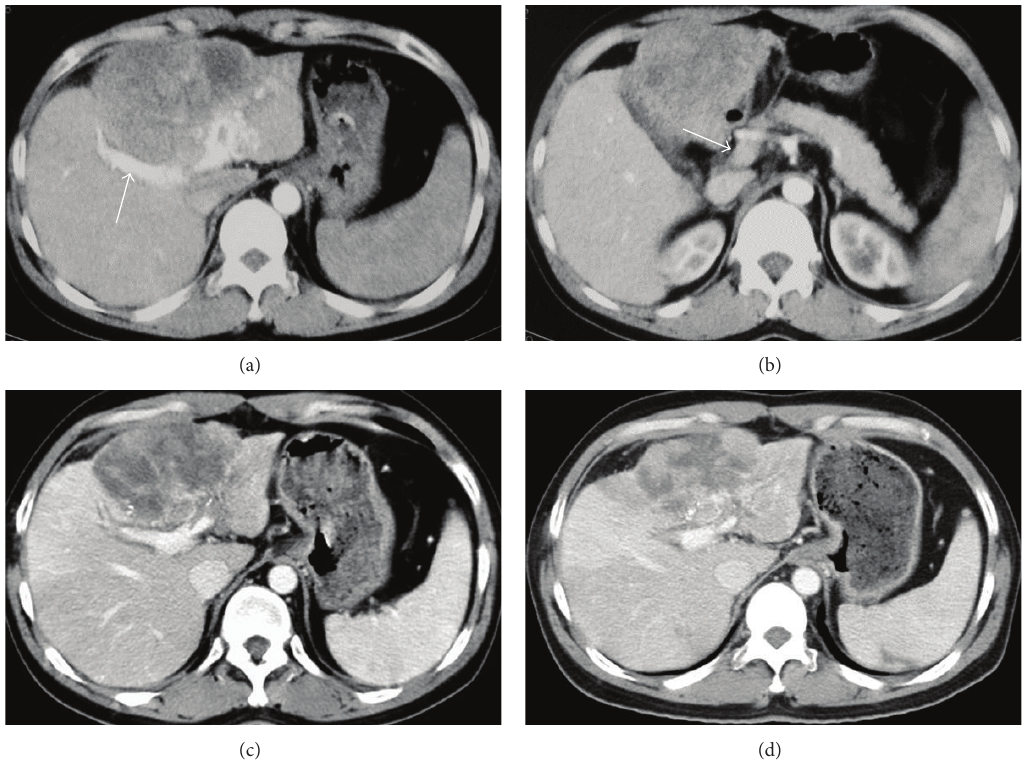
Figure 1: CT images. (a) and (b) refer to images at the initial presentation. (a) Shows a hypoattenuating mass with areas of heterogeneous enhancement in the left hepatic lobe. Visible right branch of portal vein was present in arterial phase axial CT image ((a), arrow), whereas main portal vein showed little contrast enhancement on arterial phase imaging ((b), arrow). (c) and (d) demonstrate the decreases of tumor diameter after the treatment at 59 and 152 days after the diagnosis,